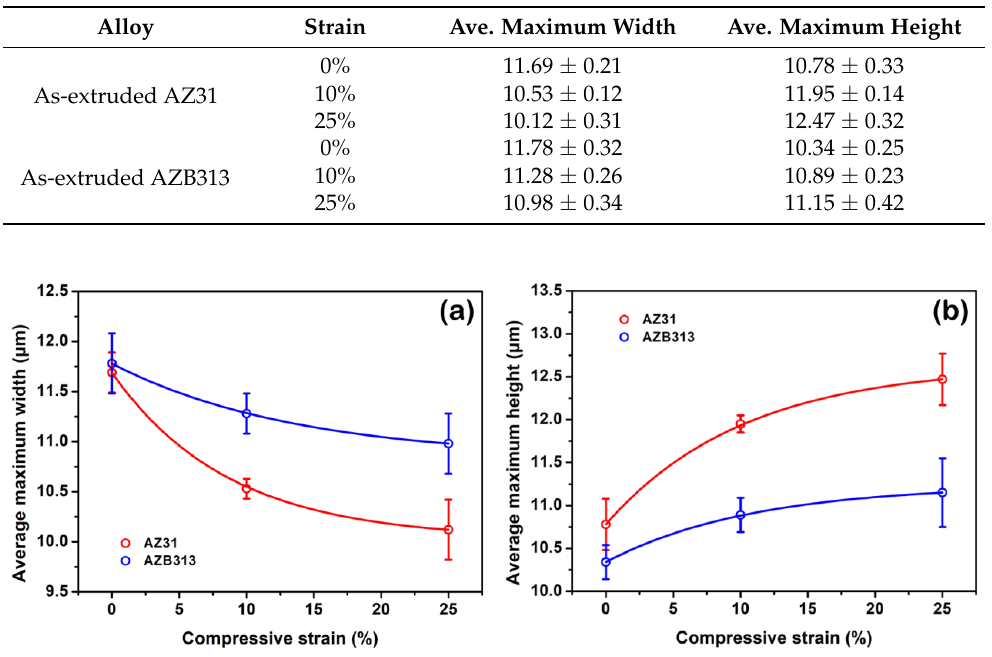
Figure 12. ( a ) Average maximum width of grains (along CD) as a function of compressive strain; ( b ) average maximum height of grains (perpendicular to CD) for as-extruded AZ31 and AZB313 alloys. Table 1. Maximum width (along CD) and height (perpendicular to CD) of G1-G8 grains marked in Figure 11 after hot compressive strain of 0 and 25% at 523 K. Unit: μ m.